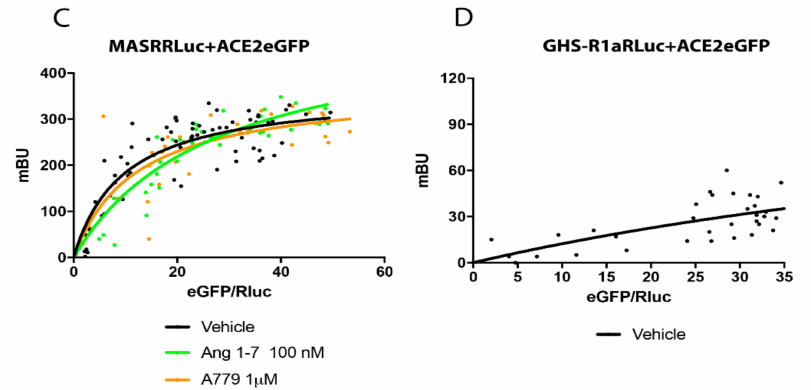
Figure 4. Interactions of RAS receptors and ACE2 as assessed by Bioluminescence Resonance Energy Transfer (BRET) assays. BRET assays were performed in HEK-293T cells transfected with constant amounts of cDNA encoding AT 1 R-RLuc (0.5 µ g) ( A ), AT 2 R-RLuc (0.4 µ g) ( B ), MasR-RLuc (0.6 µ g) ( C ), or GHS-R1a-RLuc (0.3 µ g; negative control) ( D ) together with increasing amounts of cDNA encoding ACE2-eGFP (0.1 to 1 µ g). Cells were treated (red symbols) or not (black symbols) for 25 min with selective antagonists (candesartan for AT 1 R, PD123319 for AT 2 R or A779 for MasR, both at 1 µ M; red symbols) or selective agonists (Ang II for AT 1 R, CGP for AT 2 R or Ang 1-7 for MasR, all at 100 nM; green symbols). Values correspond to experimental points from 6 independent experiments each performed in quadruplicate. BRET 50 and BRET max values were calculated by non-linear regression using Prism GraphPad software; specific parameters are as described in the